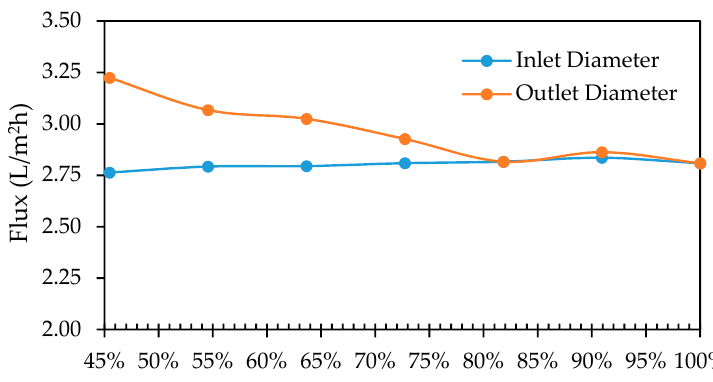
Figure 12. Total permeate flux leaving the module plotted as a function of the percentage of the reference value.